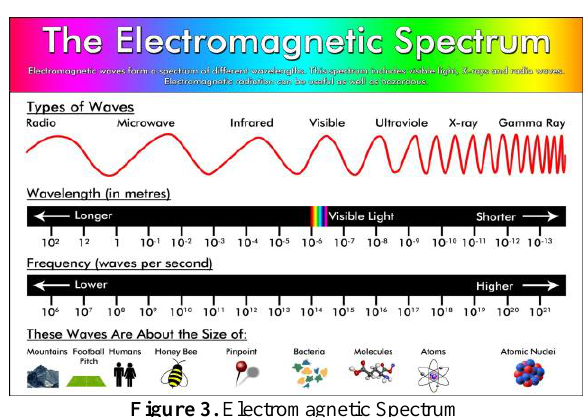
2.2 Normalized Difference Vegetation Index (NDVI) Plants use the sunlight and chlorophyll in their leaves to produce organic matter from inorganic matter. In the meantime, the share of the electromagnetic energy of the Sun corresponding to the red light and which is 0.63 µm - 0.69 µm in length, is used. Plants do not absorb electromagnetic energies with waves of 0.7 µm and are more significant and reflect them. Therefore, any satellite image measuring the reflection of near- infrared electromagnetic energy will equal a high numerical value in the concentrated part of the vegetation(Gündoğdu, 2018). The bands NDVI uses are red and near-infrared. The